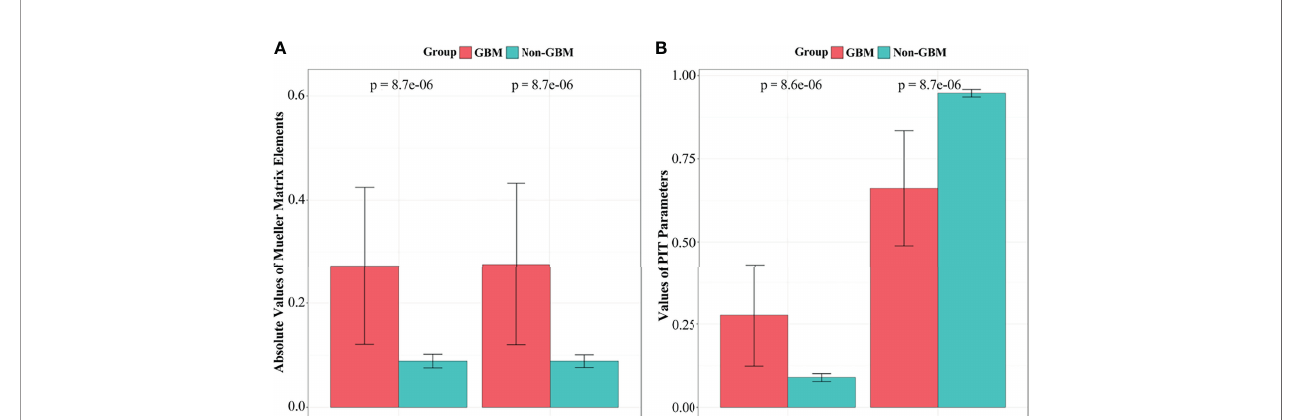
FIGURE 6 | The t -test results and the values of corresponding m 22 , m 33 , parameters (1 − D ) and t of GBM and non-GBM samples: (A) m 22 and m 33 elements, (B) parameter (1 − D ) and t